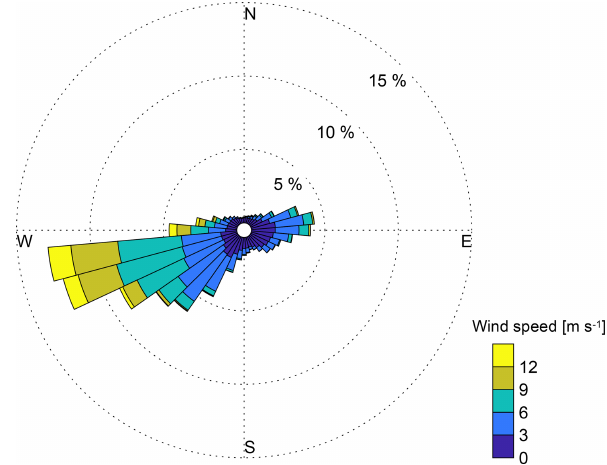
Figure 4. Wind rose computed from the data recorded by the 10m sonic anemometer on the meteorological tower P03 at the Physics Site from 29 March 2016 to 15 May